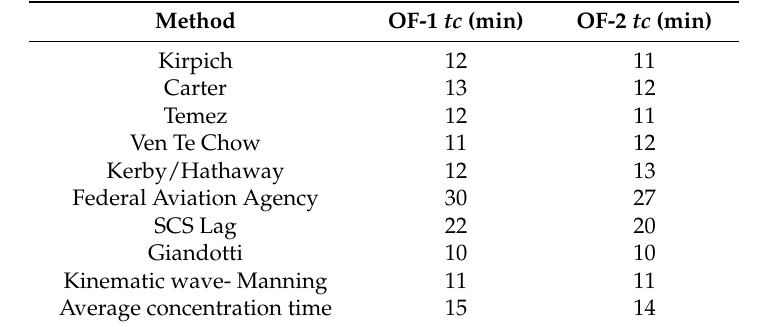
Table 8. Concentration time in OF-1 and